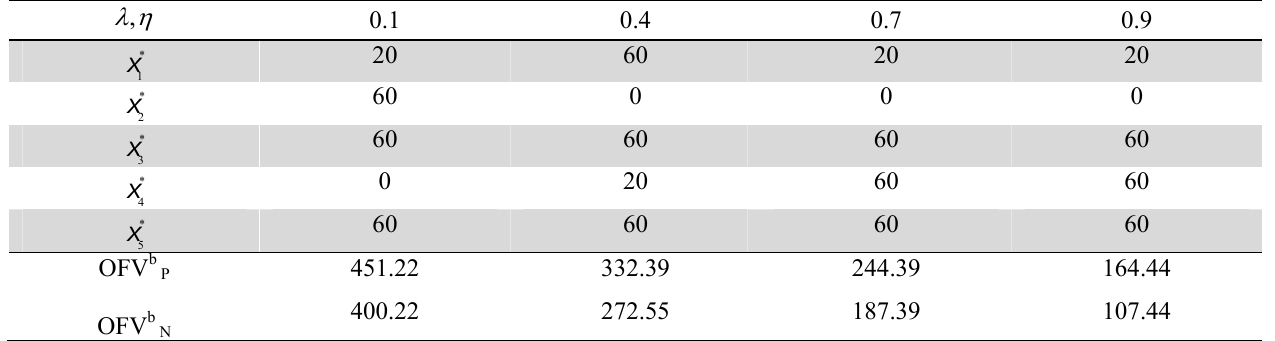
a Objective function value. Numerical results (multiobjective portfolio optimization according to first way) , 